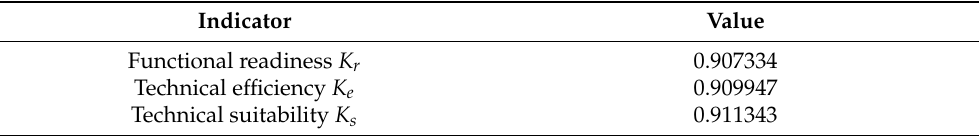
Table 7. Values of K r , K e and K s indicators in SMM.